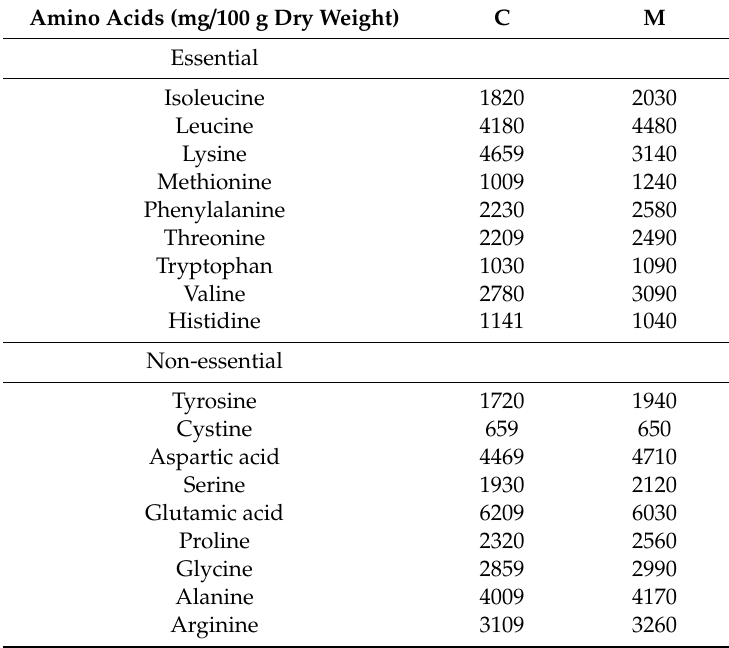
Table 2. Amino acid content of commercially available Chlorella products C and M. Amino Acids (mg / 100 g Dry